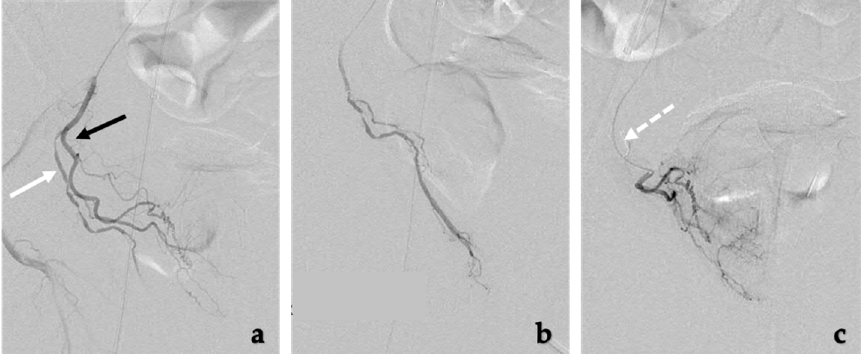
Figure 3. Coil embolization of extra-prostatic arteries. ( a ) The middle rectal artery (white arrow) and prostatic artery (black arrow) share a common trunk with short distance between middle rectal artery and prostatic artery. To safely embolize the prostatic artery with particles, the middle rectal artery can be embolized with coils, ( b ) Selective injection of the middle rectal artery prior to coil embolization, ( c ) DSA imaging of the prostatic artery after coil embolization (white dotted arrow) of the middle rectal artery shows filling of the prostate without filling of the rectum. Following these steps, the prostatic artery can now safely be embolized with particles.